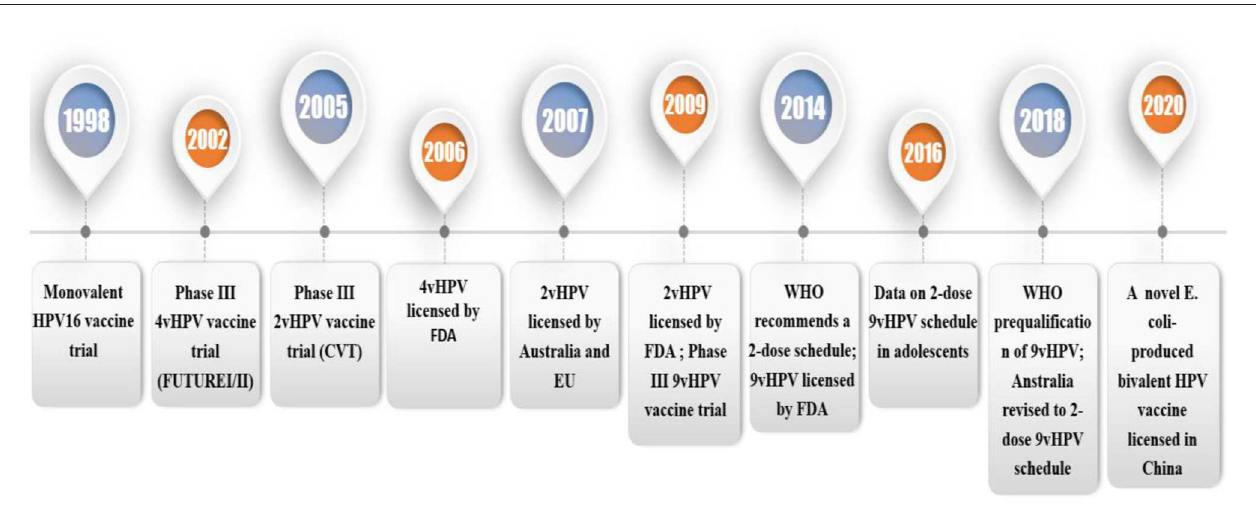
FIGURE 1 | Timeline of trials and licensure/registration of the HPV vaccines. 4vHPV, quadrivalent HPV vaccine; 2vHPV, bivalent HPV vaccine; 9vHPV, non-valent HPV vaccine; FDA, The U.S. Food and Drug Administration; HPV, human papillomavirus; EU, European Union; VLP, virus-like particle.1.1 HPV and HPV infection.